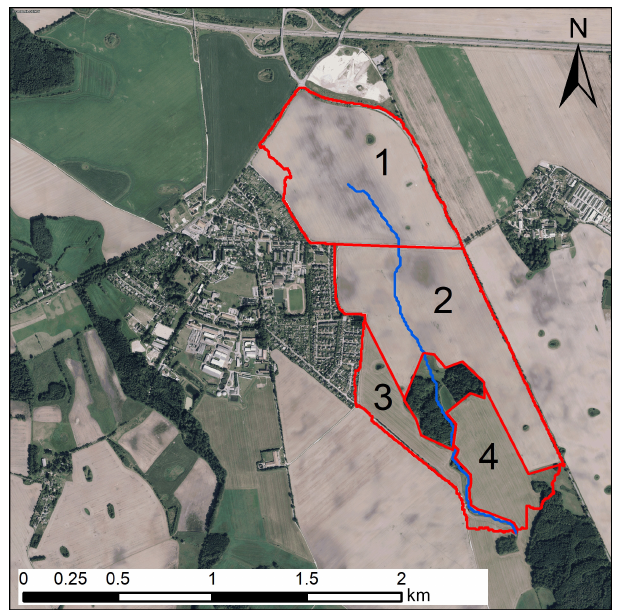
Figure 1. Study area including catchment boundaries (red), stream (blue), and arable fields